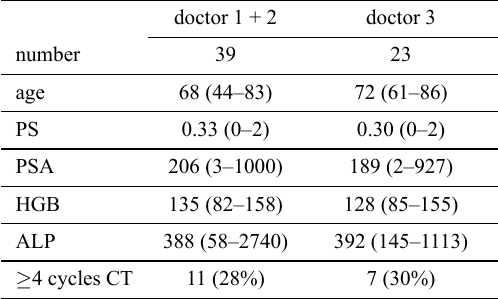
Table 1. Patients’ characteristics at baseline.